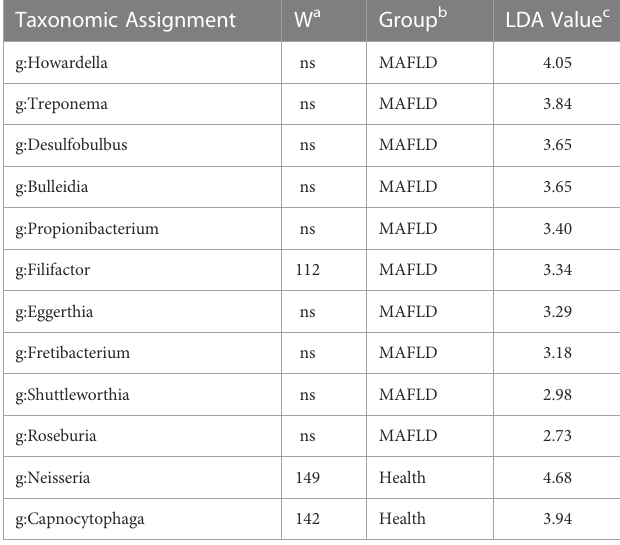
TABLE 3 Signi fi cantly different genus between the MAFLD and Control